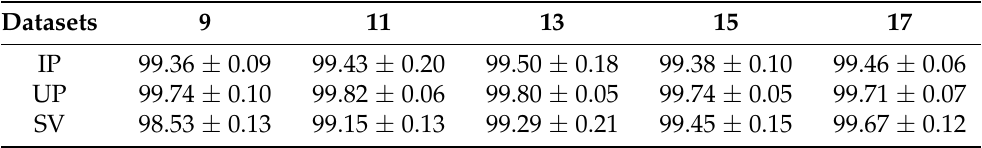
Table 7. OA (%) of PDCNet with different patch size in IP, UP, and SV datasets.